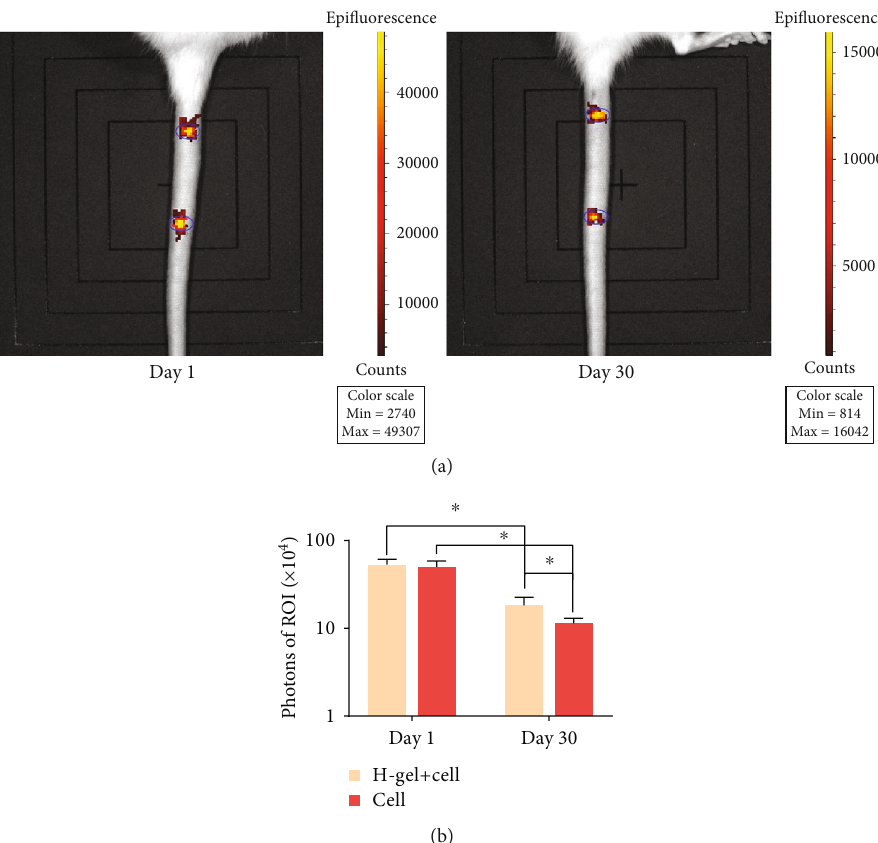
Figure 5: Cell retention in the IVD. (a) Representative images of IVIS at day 1 and day 30 after injection. (b) The histogram of luminescence of the hydrogel+cell group and cell group in the ROI in overlaying images. ROI was represented by a blue circle. The H-gel+cell group is the hydrogel+cell group. Data represent mean ± SD ; the error bars represent the standard deviation of measurements for 3 separate samples ( n = 3 ); ∗ p < 0 : 05 compared with the hydrogel+cell